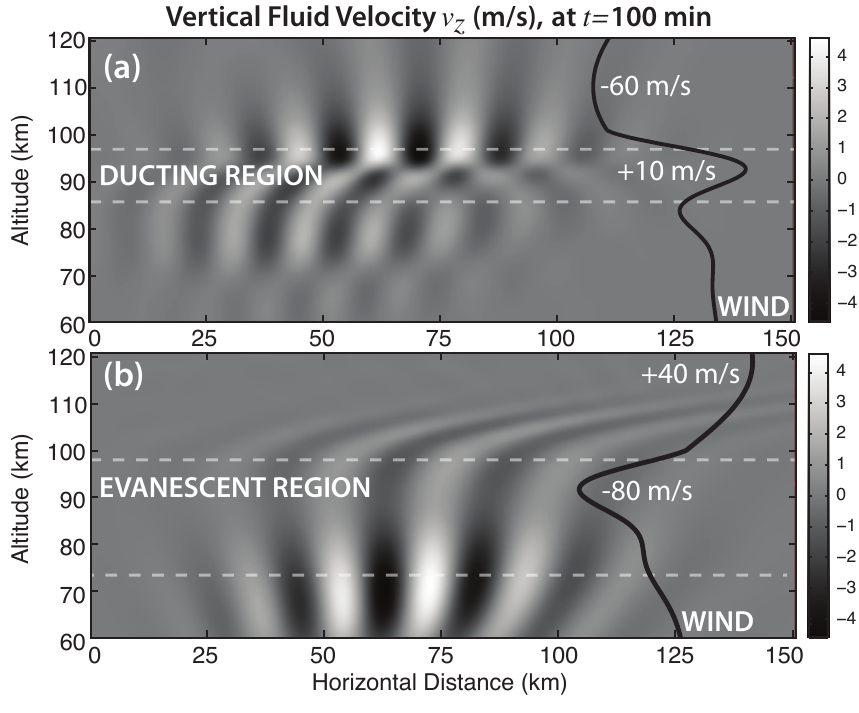
Fig. 5. Model simulation results depicting upward wave propagation through the mesopause region, for (a) wind profile consistent with non- ideal Doppler ducting from 87–97km, based on the wave event of 5 July 2003, and (b) wind profile consistent with evanescent propagation from 75–100km, based on the wave event of 30 November 2003. In both (a) and (b), data is plotted at a time 100min after start of the model simulation. The waves are seen refracted by the ambient wind field, leading to regions of propagation and evanescence, and thus weak